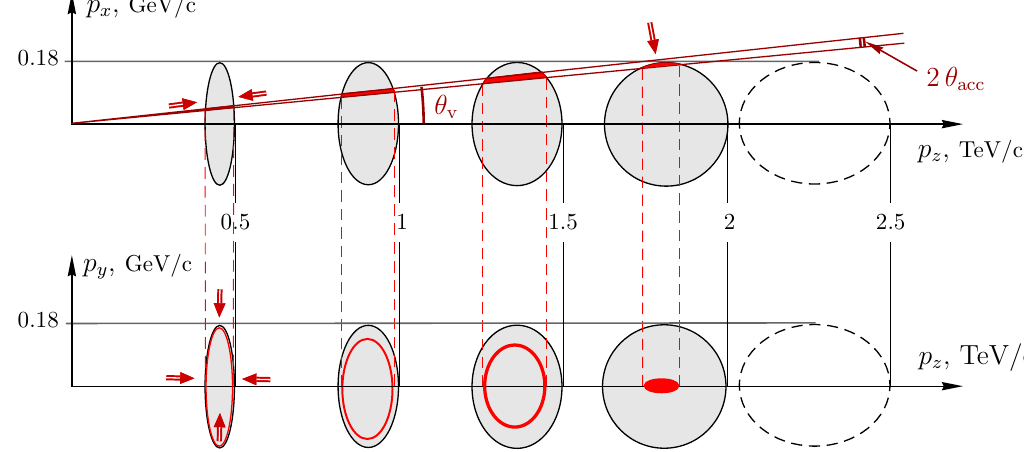
Figure 6 . Collimation of (cid:28) momenta by the second crystal. p z is chosen in the direction of the D s momentum. Each ellipsoid represents the phase space of (cid:28) leptons produced by D s mesons of speci(cid:12)c energy. The red area shows the phase space of (cid:28) leptons collimated by the second crystal. Arrows show the polarisation of (cid:28) . Scale on p x is 10 4 times smaller than on p z because (cid:13) D (cid:24) (cid:29)